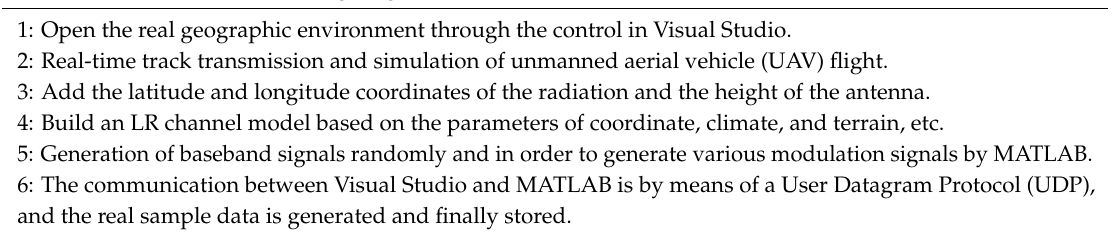
Figure 4. The geographic simulation environment. ( a ) Short-distance perspective of the real geographical environment; ( b ) Long-distance perspective of the real geographical environment. Algorithm 2. Communication signal generation